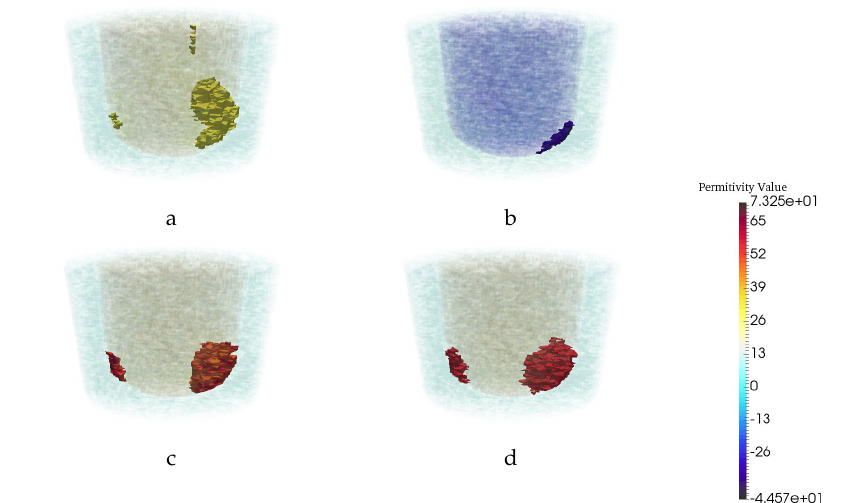
Figure 3. The detection performance using the reconstructed outputs of the Convolutional Neural Network (CNN) and CSI as well as the intersection of CSI reconstructions at the five chosen frequencies. ( a ) Receiver Operating Characteristics (ROC) curves derived from the reconstructions. ( b ) The DMTD curve.